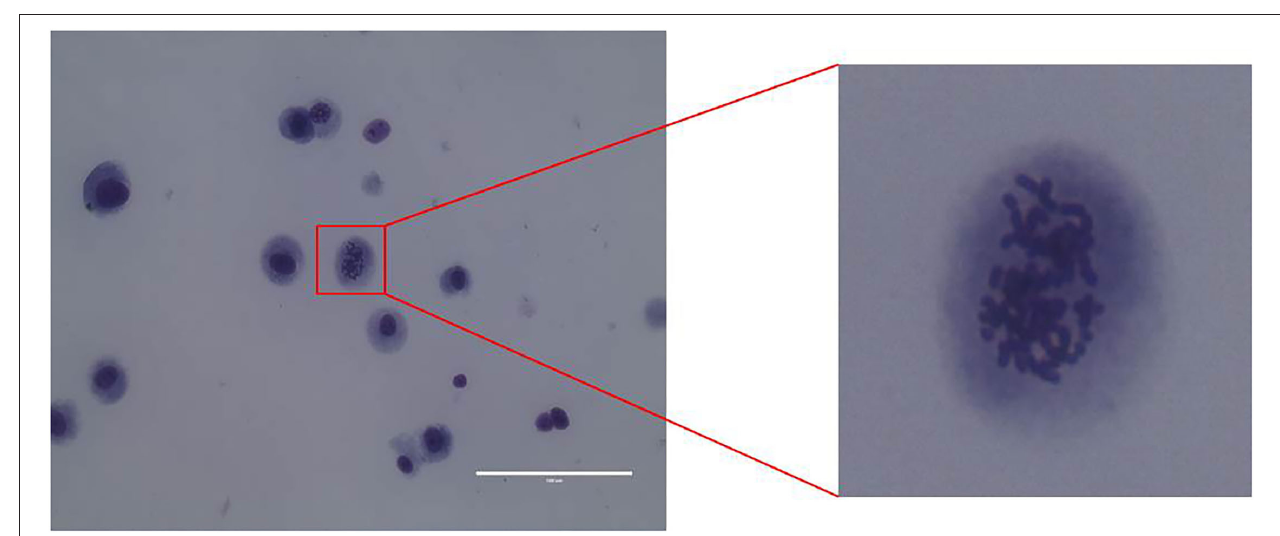
FIGURE 5 | Karyotype analysis. The modal chromosome number in the cell line was